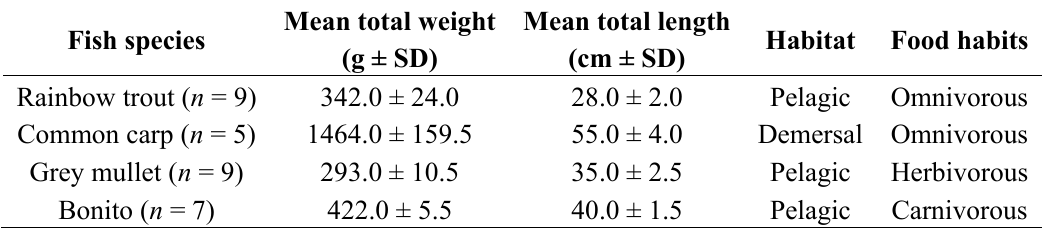
Table 1. Biometrical and biological characteristics of analyzed